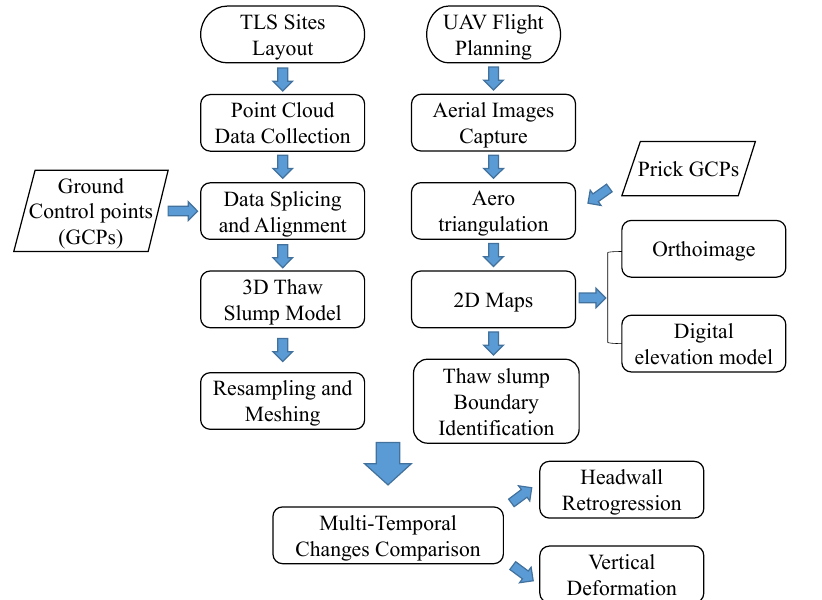
Figure 8. Data acquisition and processing flowchart of terrestrial laser scanning and unmanned aerial vehicle.